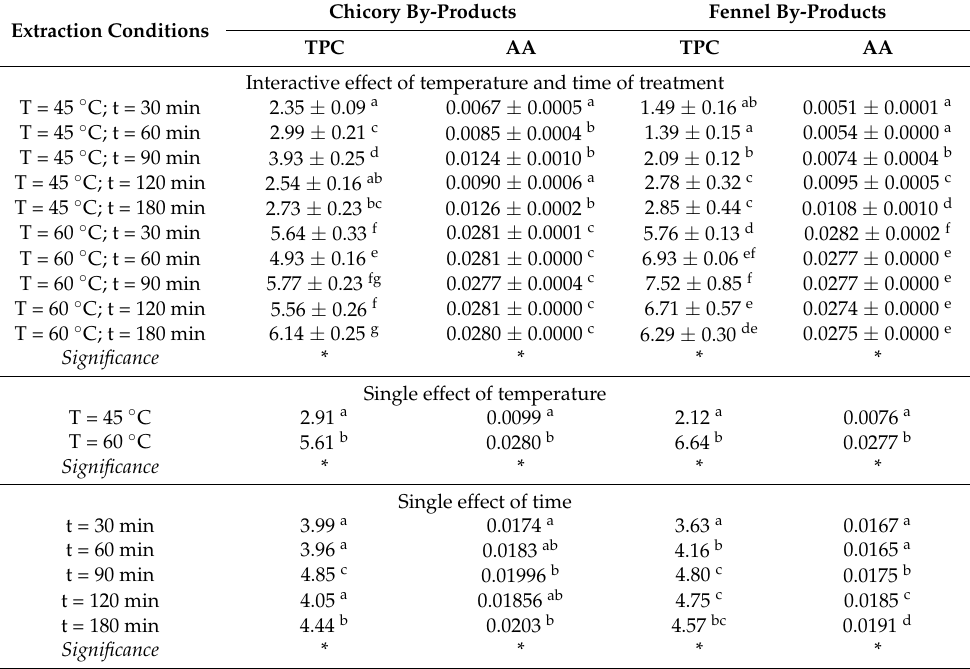
Table 1. Total phenolic content (mg gallic acid/g dm) and antioxidant activity (mmol Trolox/g dm) of extracts obtained through conventional extraction: single and interactive effects of temperature and time of